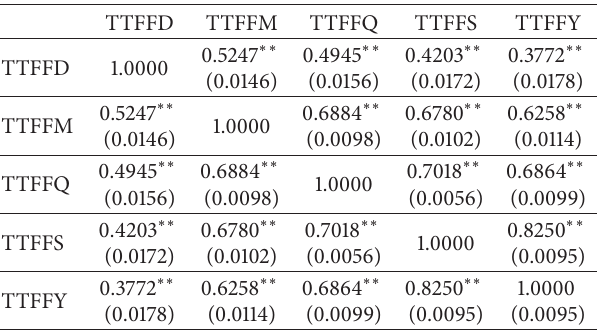
Table 5: Estimated parameters of natural gas portfolio for multi- variate Gaussian copula.